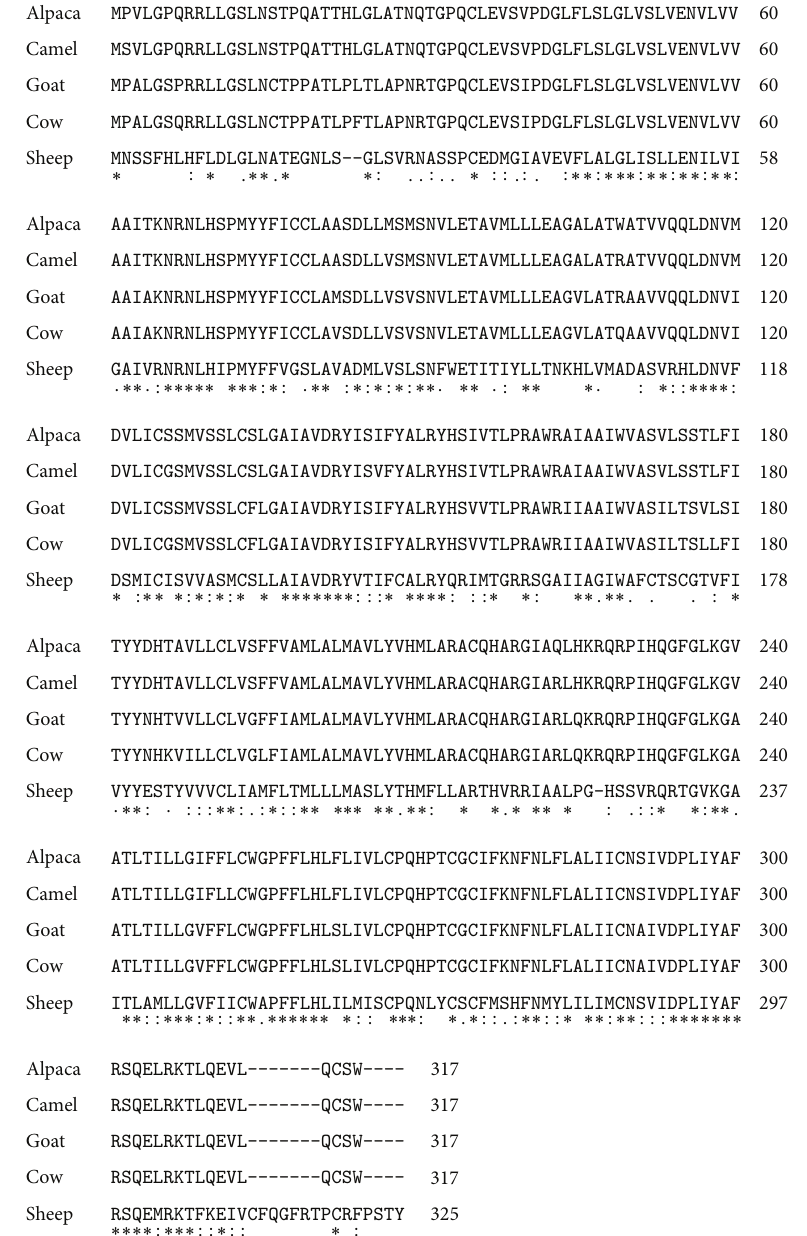
Figure 2: ClustalW alignment of MC1R amino acid sequences from alpaca, camel, goat, cow, and sheep shows the degree of identity.